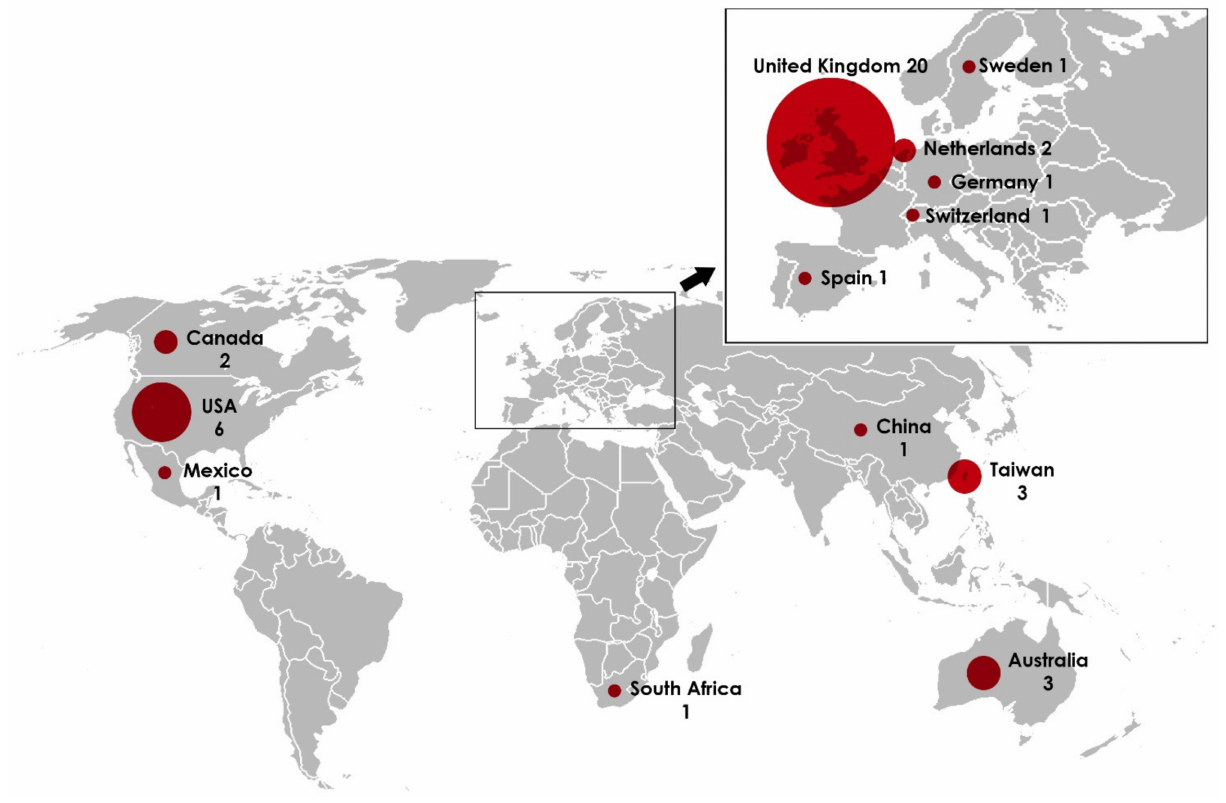
Figure 3. Geographical distribution of the studies